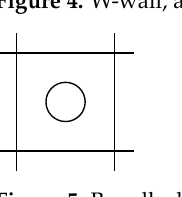
Figure 4. W-wall, abbrev.